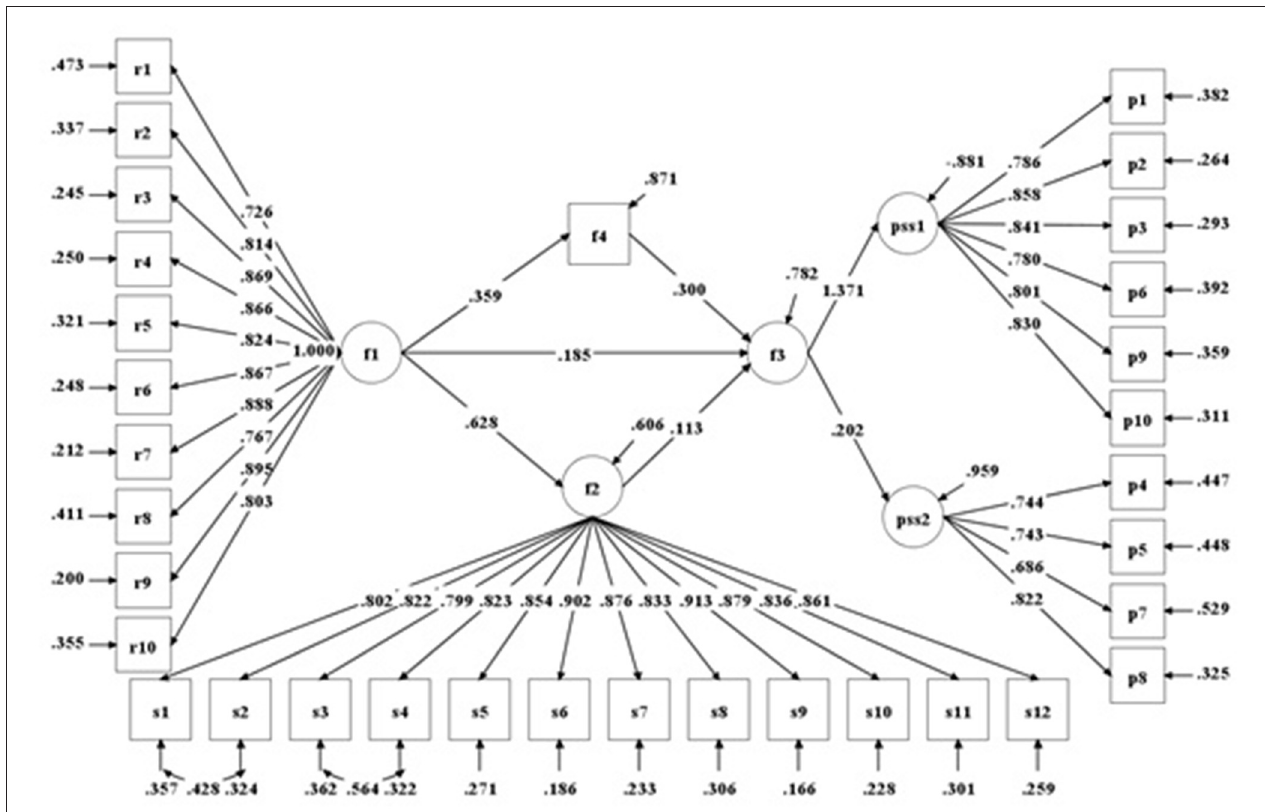
FIGURE 4 | Structural equation model of social support and perceived stress (standardized coefficients in Model 1) (all path coefficients are significant, p <